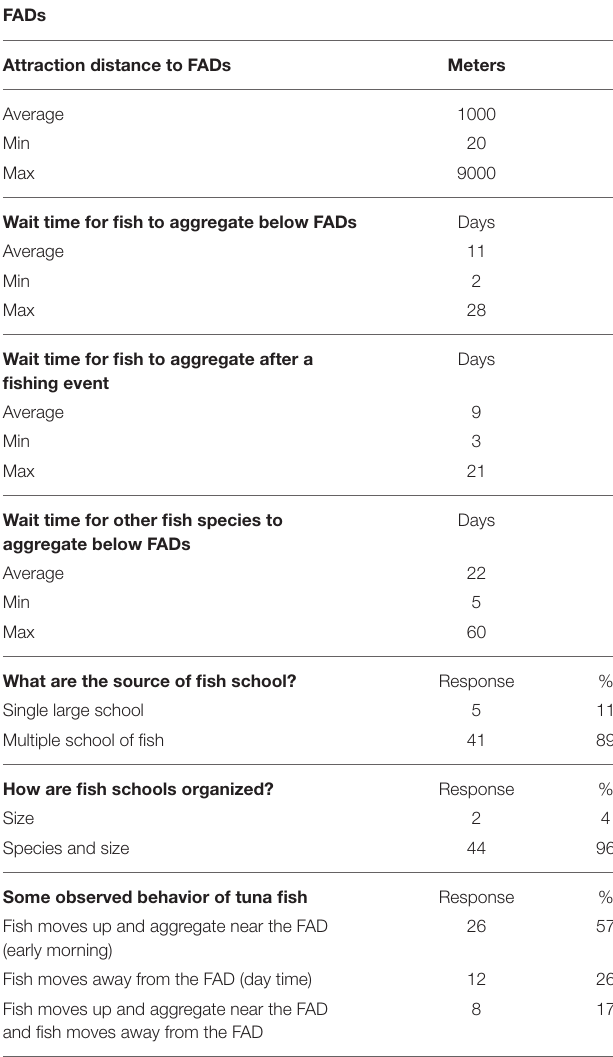
TABLE 1 | Fishers’ responses related to attraction behavior of fish to anchored